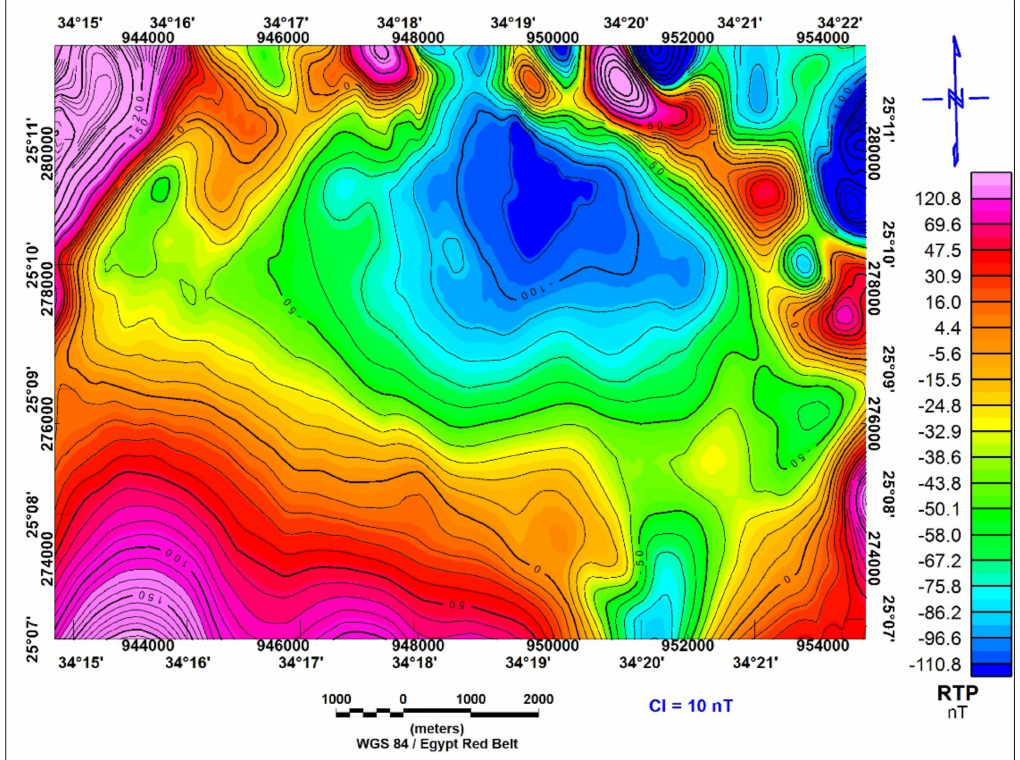
Figure 5. Reduced to the north magnetic pole (RTP) map of Homrit Waggat